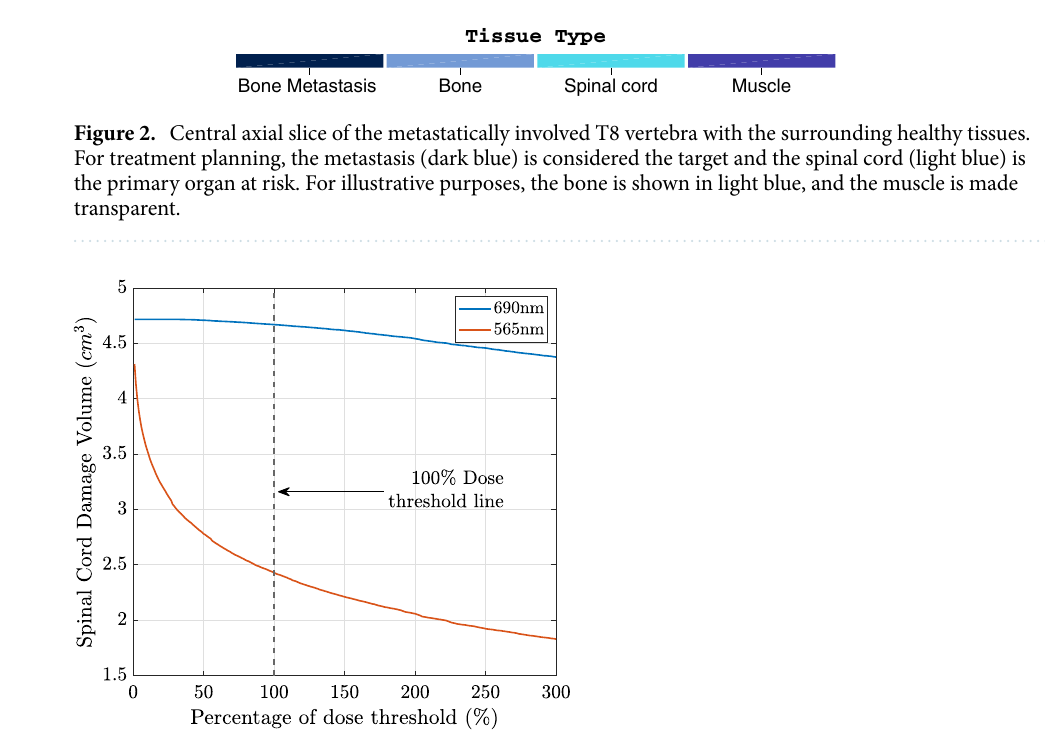
Figure 3. Dose-volume histogram of the spinal cord, for the 4 cut-end fibres configuration at the 690 nm and 565 nm wavelengths for treatment optimized to 90% tumour reduction.